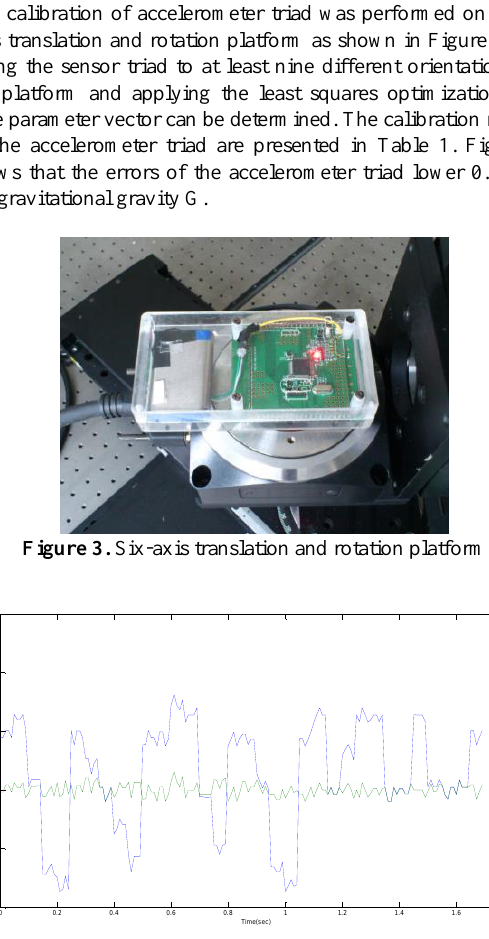
Figure 4. The calibration results of acceleration triad Axis